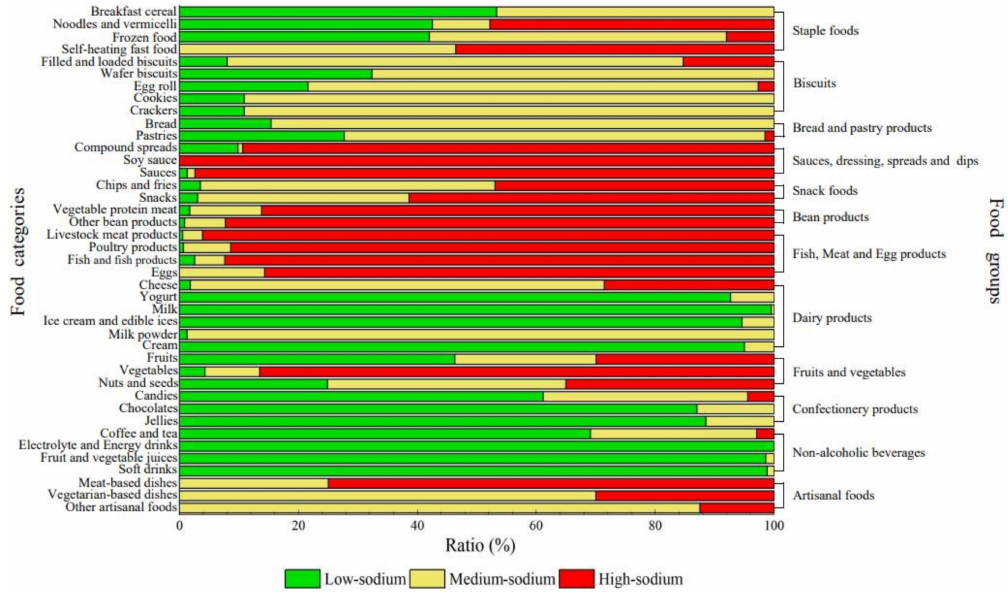
Figure 2. The proportion of low-, medium- and high-sodium content in food